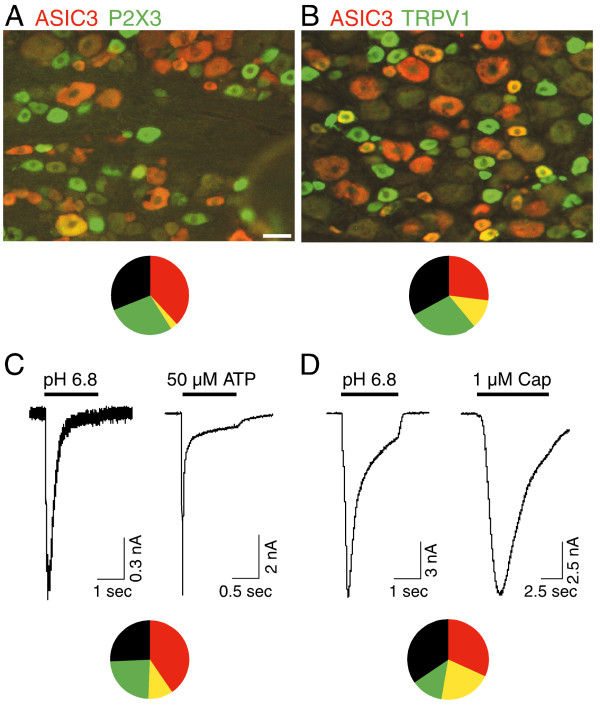
ASIC3 expression compared to other nociceptive ion channels. DRG sections double-labeled for ASIC3 (red) and either P2X3 (green, A) or TRPV1 (green, B); double-labeled cells are yellow or orange. Circle charts show the relative distribution of the three receptors among all DRG neurons. ASIC3 and P2X3 expression overlapped in only 4% of neurons, while some 35% of ASIC3-positive neurons also express TRPV1. The rare cells positive for both ASIC3 and P2X3 were large (eg. cell at lower left in A). 1406 cells counted for A; 995 for B. C, D, electrophysiological recordings reveal a qualitatively similar expression pattern for currents conforming to ASIC3, P2X3, or TRPV1. The cell that generated the currents in C counts as a co-expressor of ASIC3 and P2X3, fitting into the yellow bin in the circle plot. The cell in D is a co-expressor of ASIC3 and TRPV1. Cells were counted positive if they had at least 0.3 nA of current in response to pH 6.8 (ASIC3+), 50 μM ATP (P2X3+; transient current only), or 1 μM capsaicin (TRPV1). 182 cells recorded for C; 169 for D.